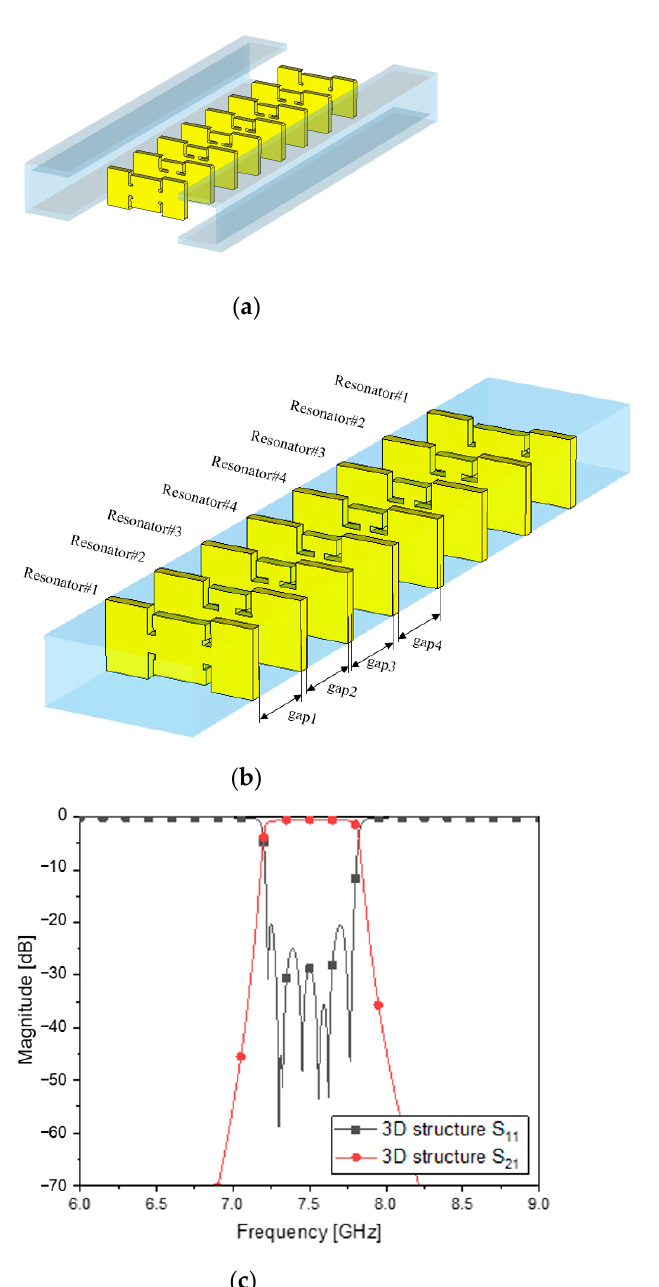
Figure 6. Combining eight ZORs through the gaps for coupling ( a ) open structure, ( b ) complete structure and ( c ) S 11 and S 21. Table 6. The values of the physical dimensions of the eighth-order filter.